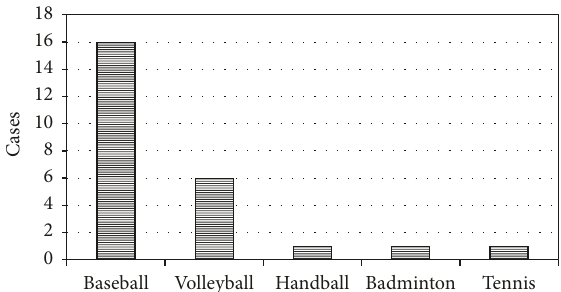
Figure 1: Sports activity . Cause of sports activity was 16 being baseball players, 6 volleyball players, 1 handball player, 1 badminton player, and 1 tennis